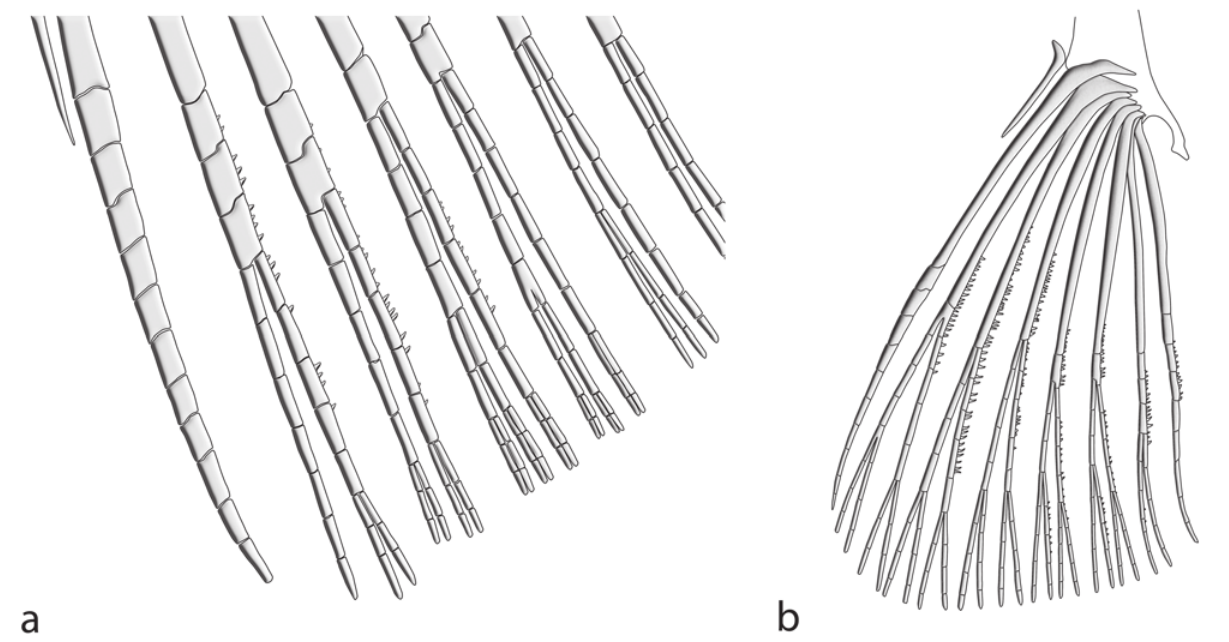
Fig. 23 Hooks on anterior anal-fin rays (a) and pelvic-fin rays (b) of Charax pauciradiatus , MZUSP 19538, male, 86 mm SL.